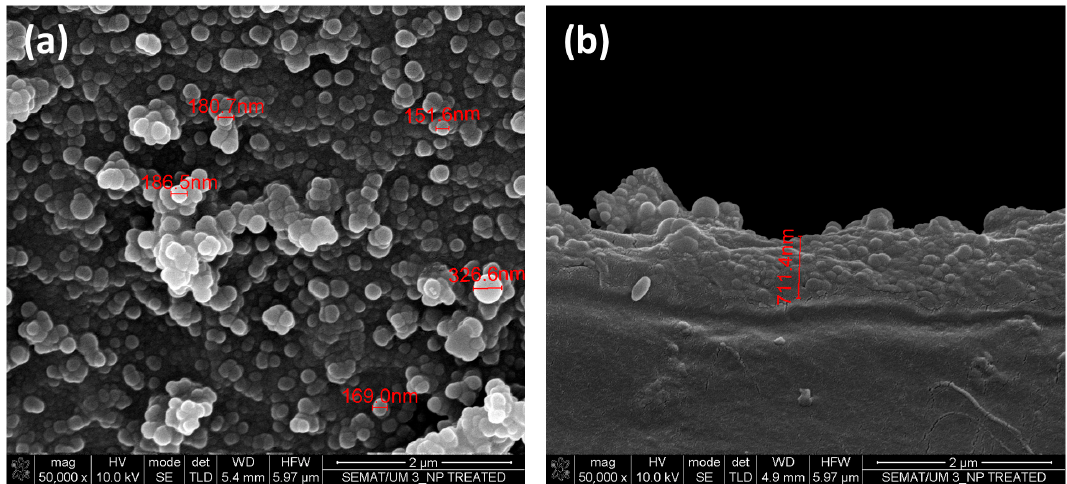
Figure 5. SEM images of PET NP modified surface ( a ) top view ( b ) cross-section view at a magnification of 50,000 ×.